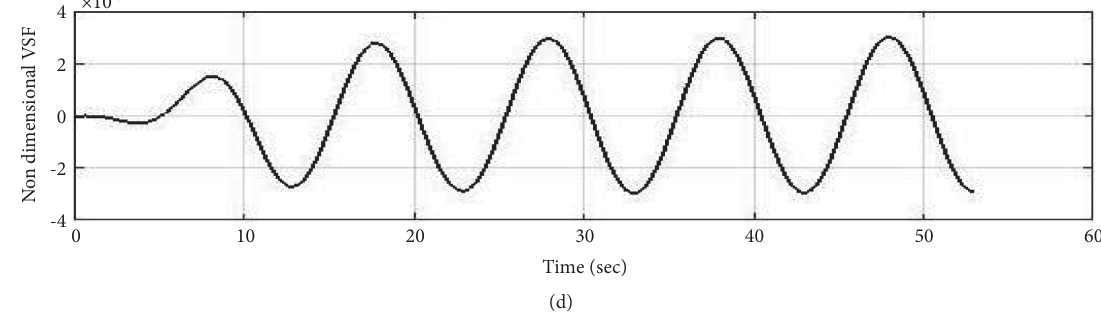
Figure 5: Symmetric load time histories for ULC and S175 container ships ( F